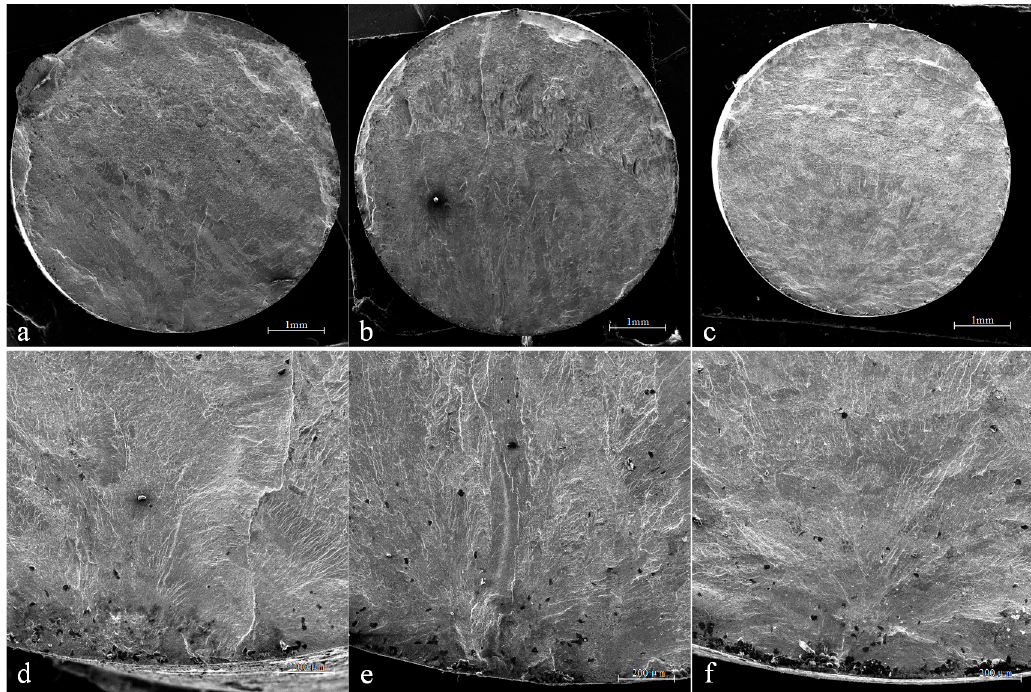
Figure 8. Fatigue fractures of the different specimens. ( a ) Overall fracture morphology and ( d ) crack source characteristics of Group 1 specimens, ( b ) overall fracture morphology and ( e ) crack source characteristics of Group 2 specimens, ( c ) Overall fracture morphology and ( f ) crack source characteristics of Group 3